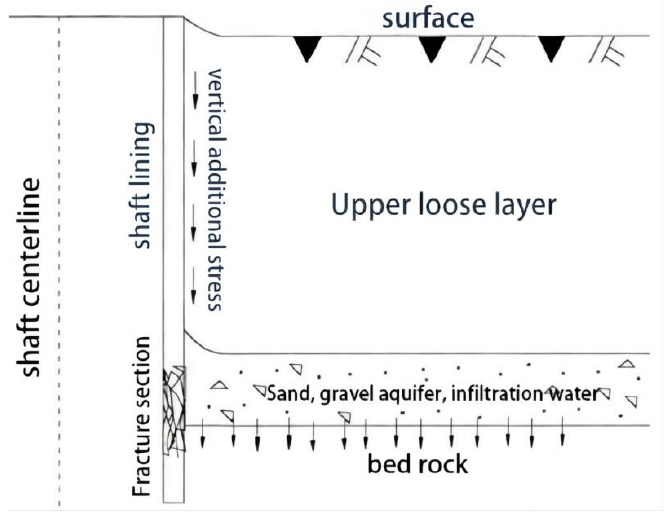
Figure 1. Schematic diagram of shaft lining fracture mechanism.